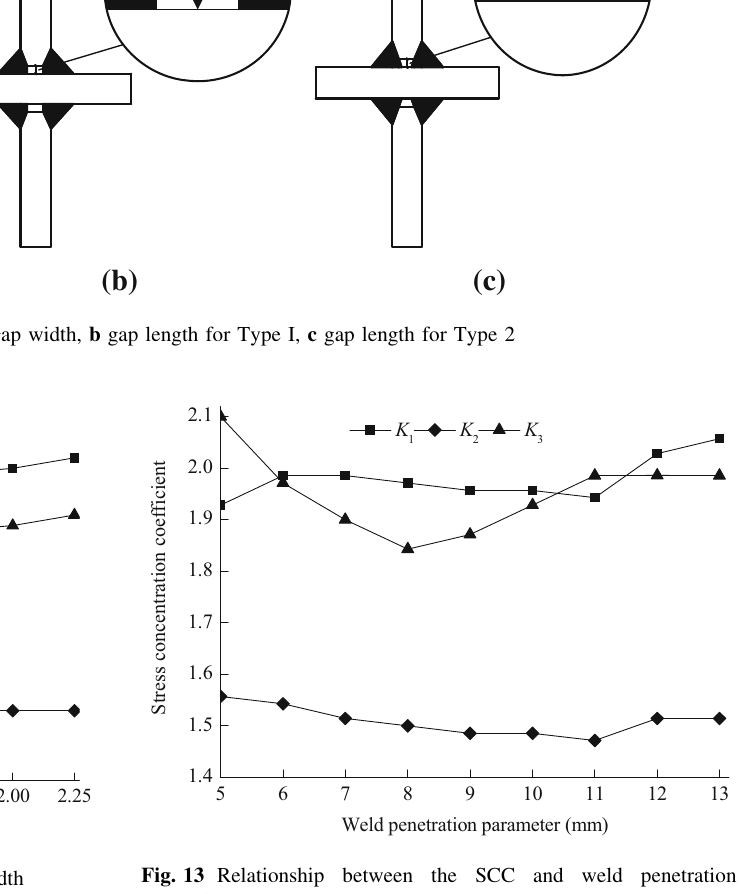
Fig. 12 Relationship between the SCC and plate gap width